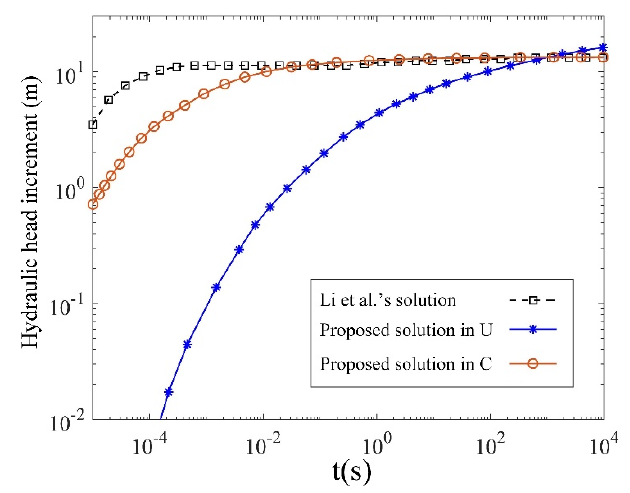
Figure 7. Comparison of the hydraulic head increment − time curves of proposed and Li et al.’s [17] solutions.